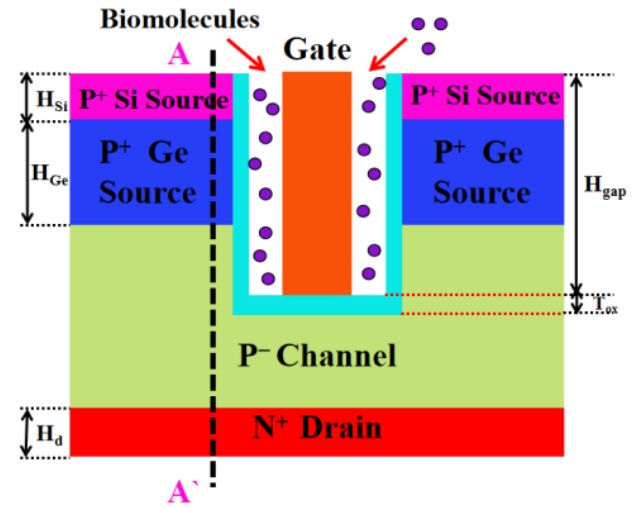
Figure 1. Schematic cross-sectional view of DM-SSTGTFET biosensor. Table 1. Device parameters used for the simulation.